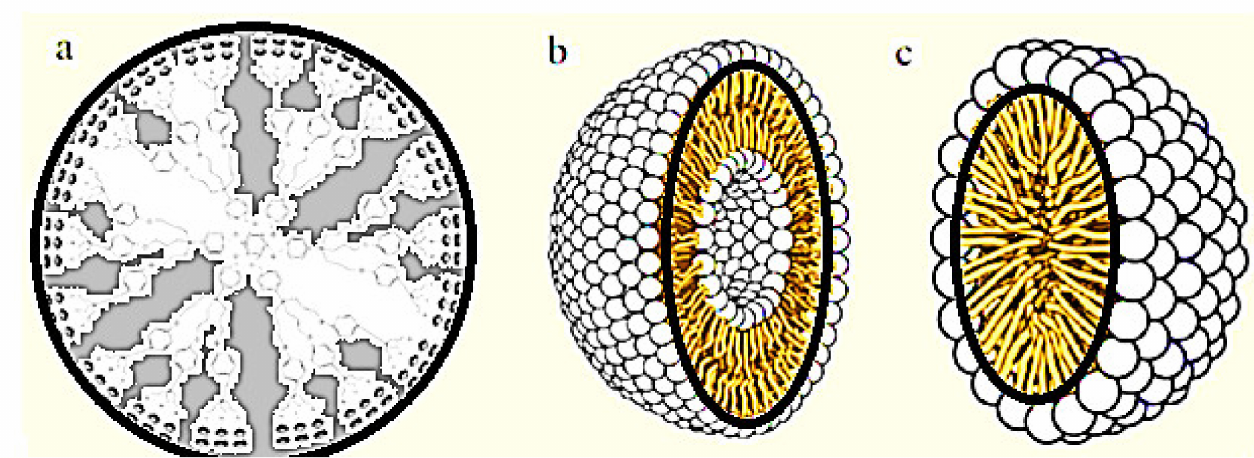
Figure 1. Structures of some organic NPs ( a ) dendrimers, ( b ) liposomes, ( c ) micelles.